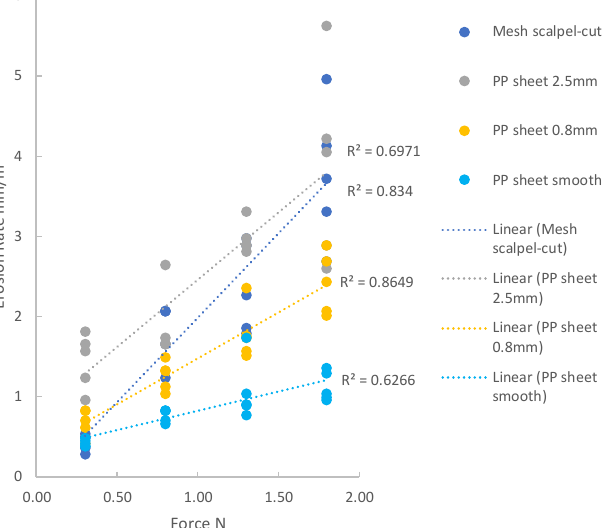
Figure 9. All results from tests using a stroke of 2 mm. Erosion rate as a function of applied force with linear fits and R 2 values.